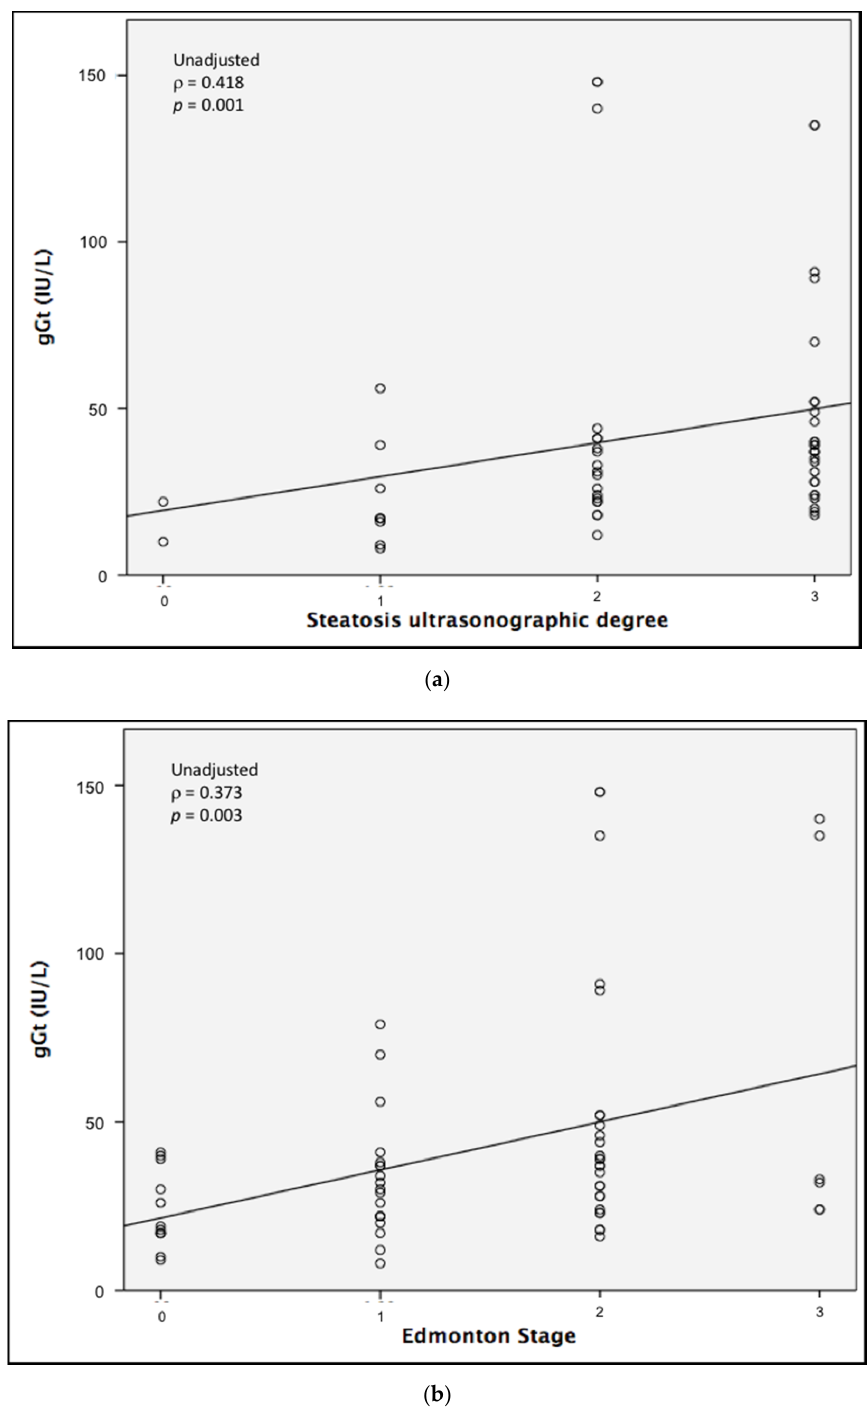
Figure 1. Spearman’s correlation between levels of gamma ‐ glutamyl transferase (gGT) and ( a ) ultrasonographically measured degree of steatosis or ( b ) Edmonton stage. After following the VLCKD, a significant weight loss was observed in all groups, with a significant reduction in fat mass and degree of steatosis (Table 3). A significant reduction in